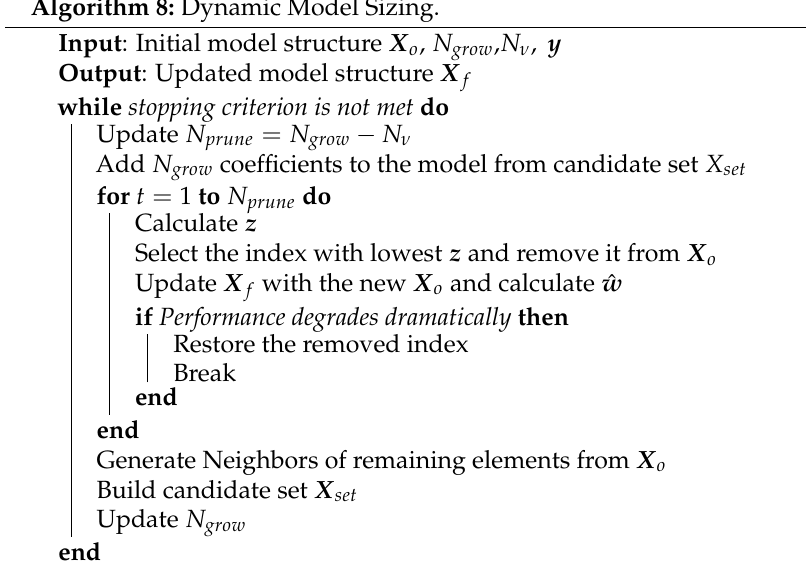
Algorithm 8: Dynamic Model